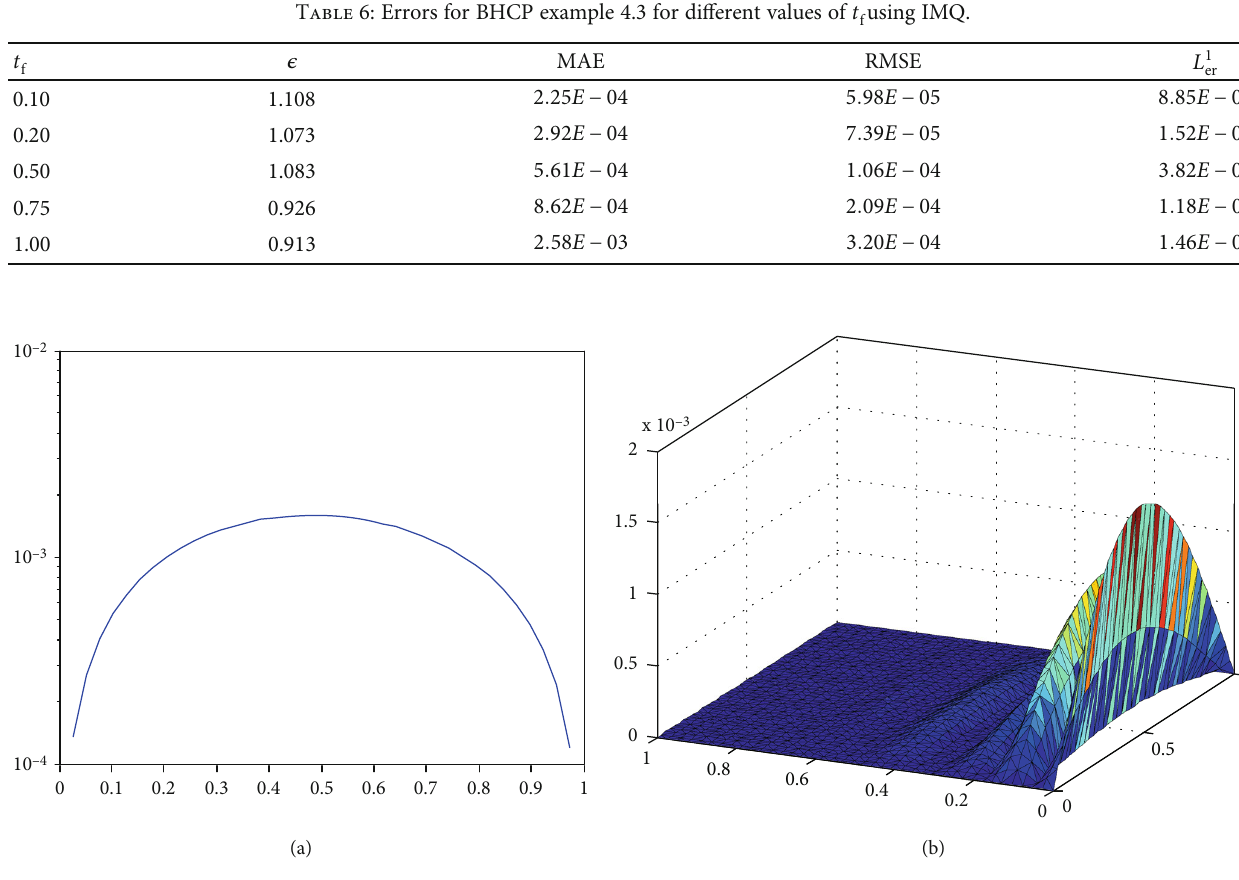
Figure 7: MAE for example 4.3 using MQ with ϵ = 0 : 823 , N = 40 × 40 , and t